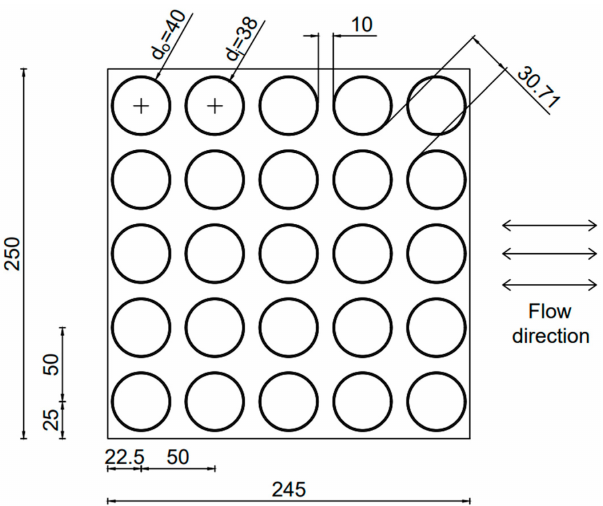
Figure 10. Design of cylinder system with an external diameter of 40 mm in heat exchanger